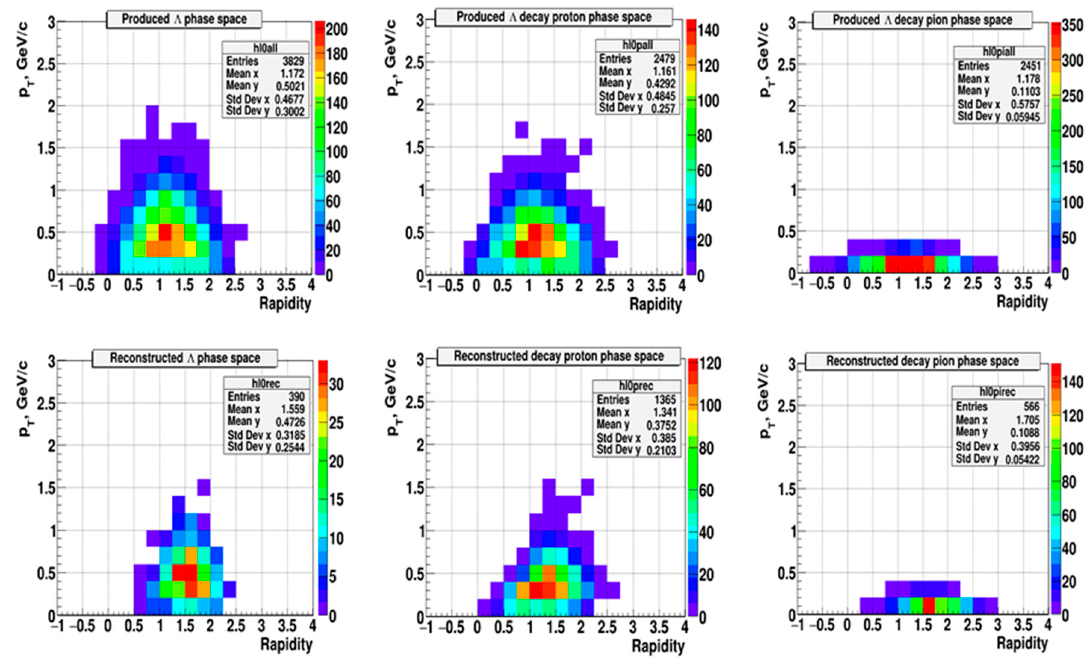
Figure 7. Phase space distributions as function of transverse momentum and rapidity for lambdas ( left column ), protons from lambda decays ( center column ), and pions from lambda decays ( right column ), as generated with the DCM-QGSM code for central Au + Au collisions at a beam kinetic energy of 4 A GeV (upper row), and reconstructed based on hits in the hybrid tracking system (lower row).